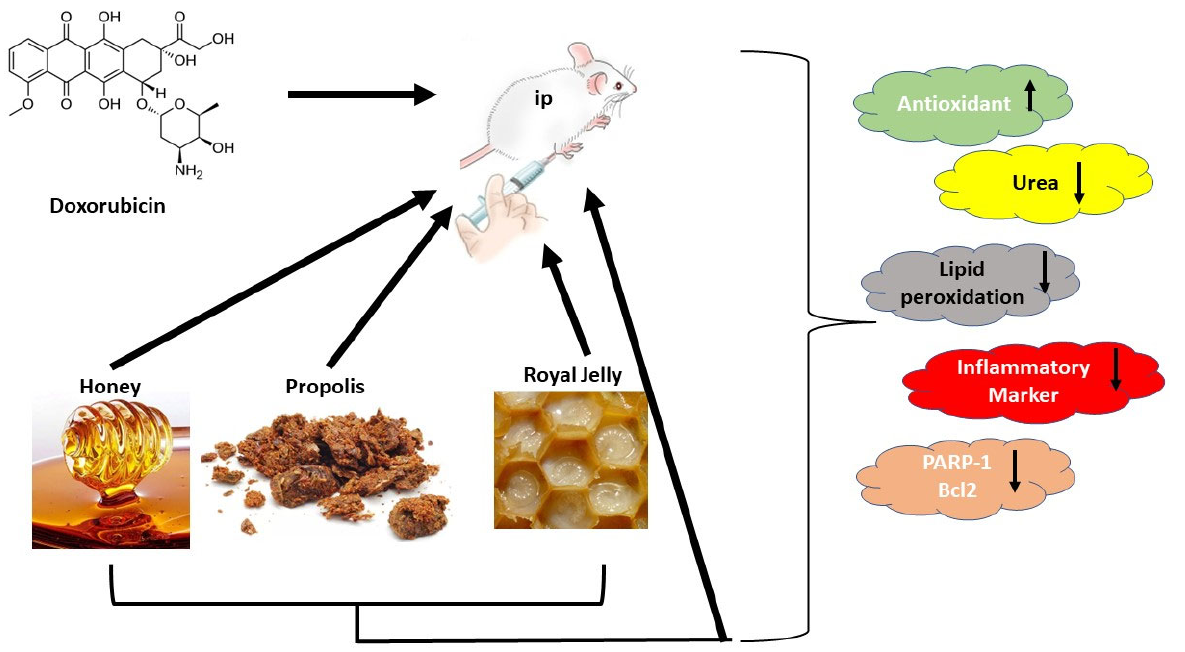
Figure 7. Schematic diagram showing the experimental design and relevant results. Upregula ‐ tion of the parameter. Downlegulation of the parameter.